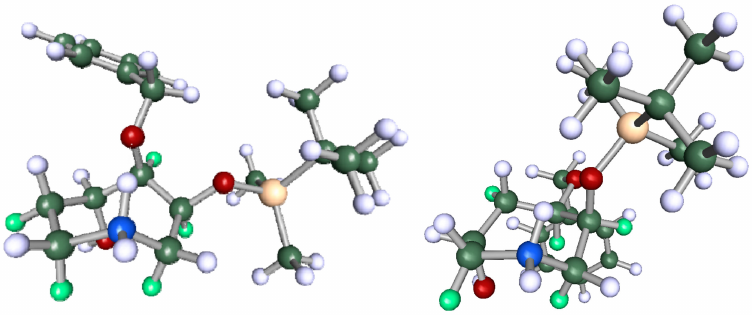
Figure 3. Global lowest-energy structure of (5 S )-4a ( left ) and (6 R )-4b ( right ), α -protons coloured